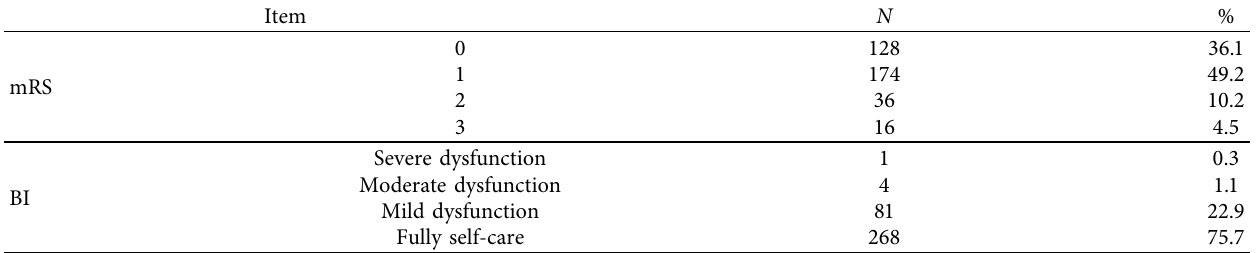
Table 3: Te disability level and activities of daily living level of the 354 efective patients.